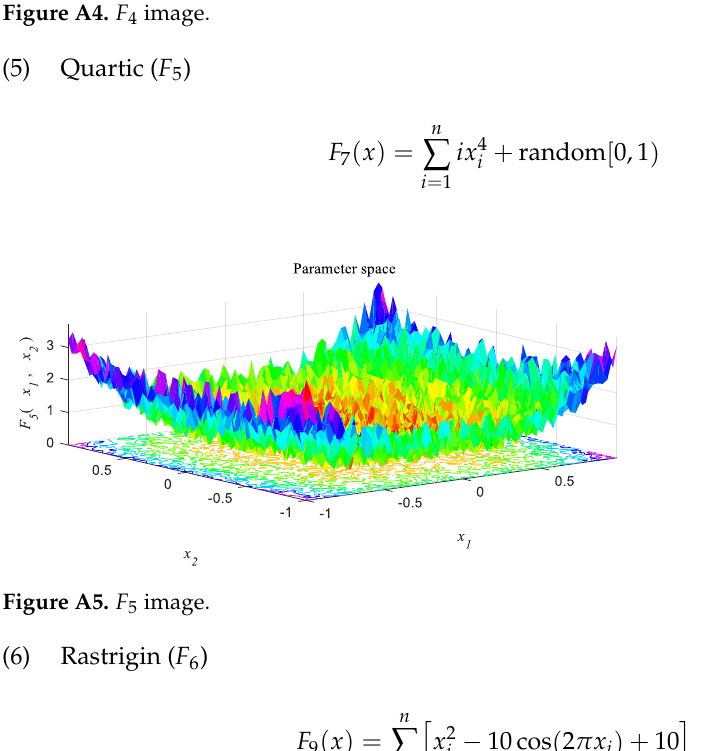
Figure A4. F 4 image.